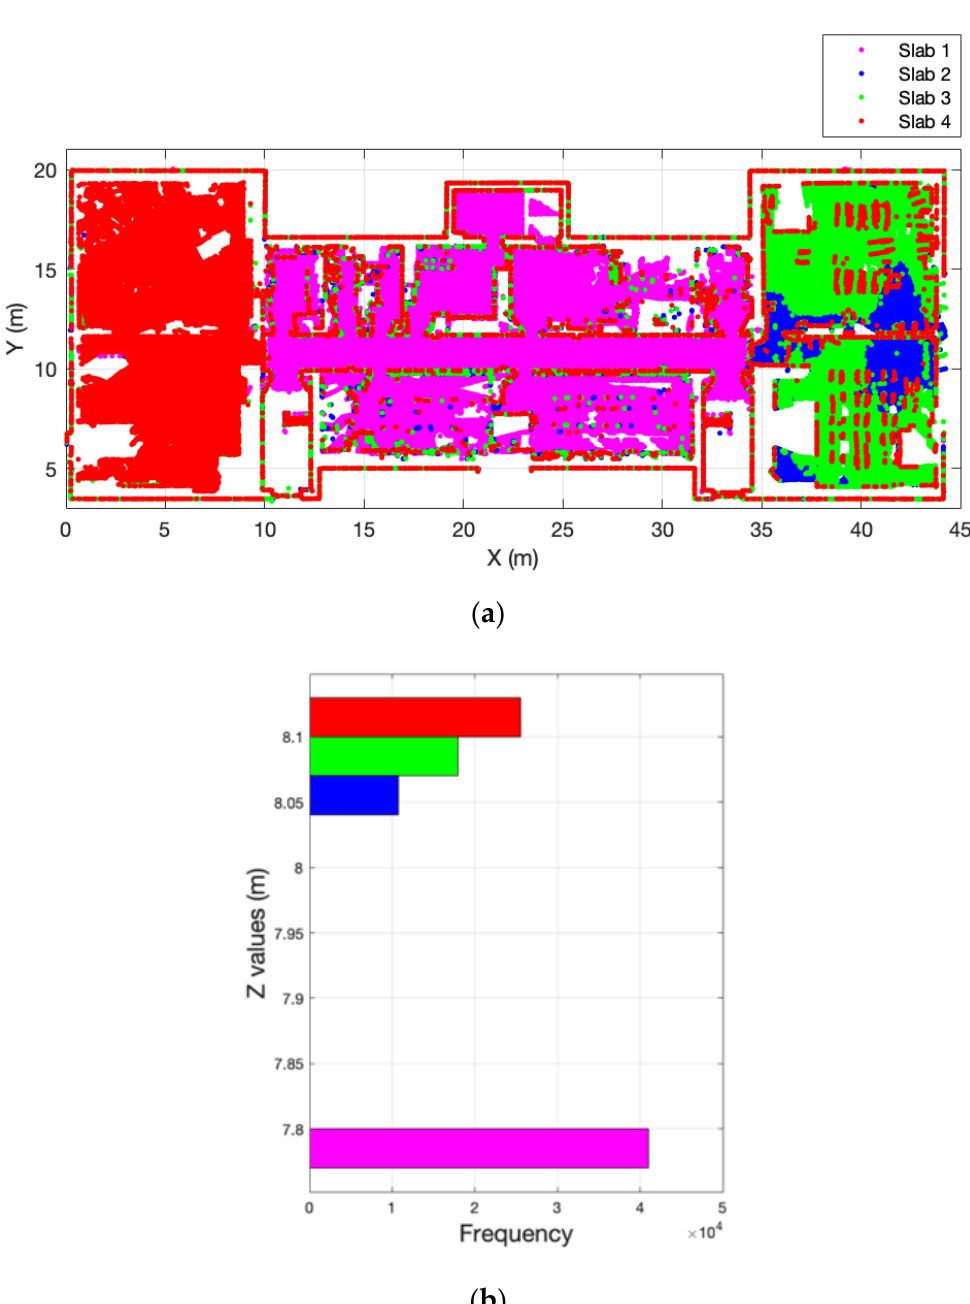
Figure 4. Old Sun Main Building Storey 3: ( a ) Floor slab constructed from four planar slabs (magenta, blue, green, and red) extracted from the vertical histogram; ( b ) The vertical histogram of the floor slab. Once the floor and ceiling planes have been correctly identified, the point cloud is split up into single-storey point clouds by finding the points occurring between these extracted floor and ceiling slabs. To do this, an alpha shape boundary is computed using the floor and ceiling slabs for each storey, and the entire dataset is searched for points that are located within the detected floor and ceiling slabs. Once these individual storeys have been created, the algorithm can continue the point cloud modelling